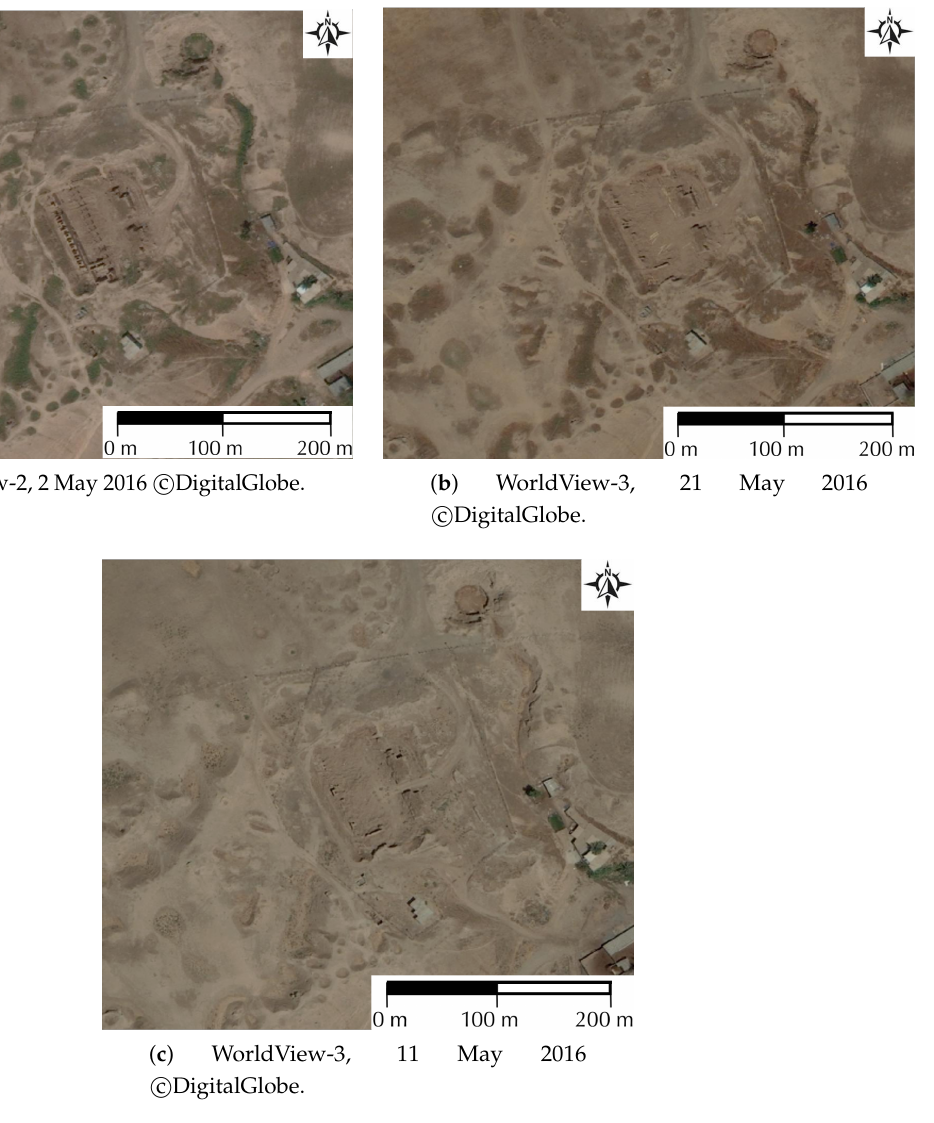
Figure 20. Satellite imagery of Sennacherib Palace